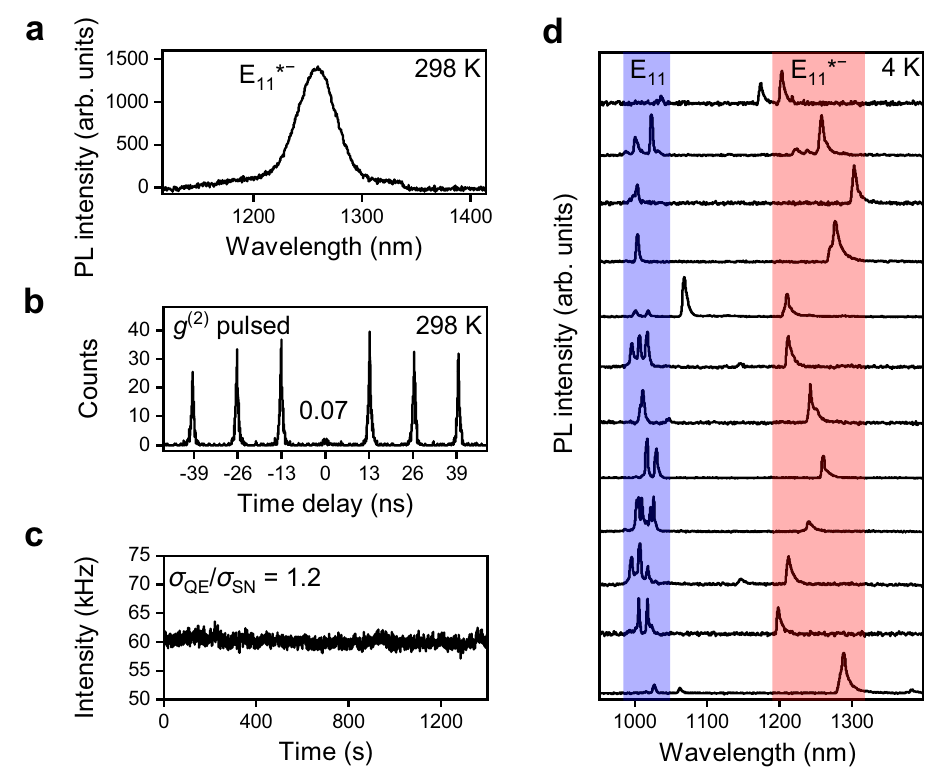
Fig. 3 PL characteristics of individual (6,5) SWNTs with E 11 * − defects. a PL spectrum of a single (6,5) SWNT functionalized with 2-iodoaniline embedded in a polystyrene matrix at room temperature (298 K) collected under continuous wave excitation at the E 11 transition. b Second-order photon-correlation function g (2) (t) of E 11 * − emission at room temperature, con fi rming high single-photon purity (93%). c PL time trace showing a count rate fl uctuation near the shot-noise limit. The deviation of the PL intensity distribution of the emitter ( σ QE ) from the Poisson distribution of the detector shot noise ( σ SN ) is expressed as σ QE = σ SN ¼ ððh n 2 i (cid:2) h n i 2 Þ = h n iÞ 0 : 5 , with n being the number of PL counts within a 0.1 s timeframe. d PL spectra of 12 individual (6,5) SWNTs functionalized with 2-iodoaniline and embedded in a polystyrene matrix recorded at 4 K. The spectral ranges of the E 11 (blue) and E 11 * − (red) emission peaks are